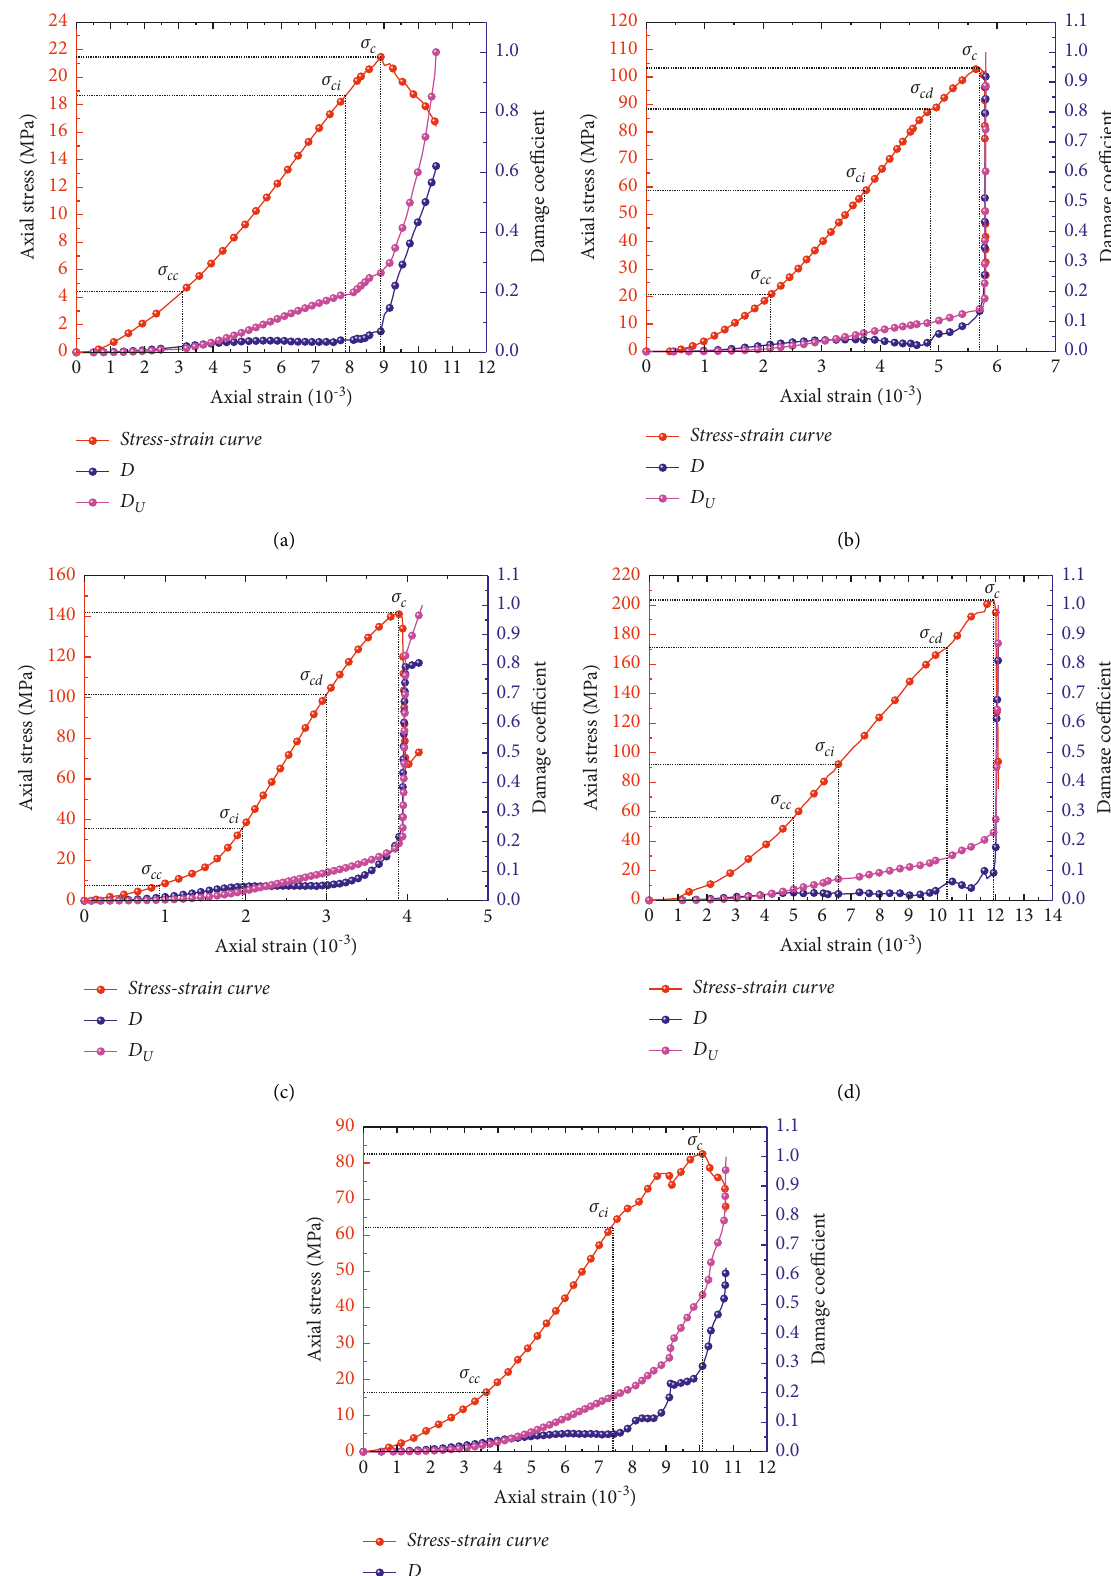
Figure 5: Variation of Damage variables D and D U in the different types of rocks. (a) Coal. (b) Granite. (c) Marble. (d) Shale. (e)